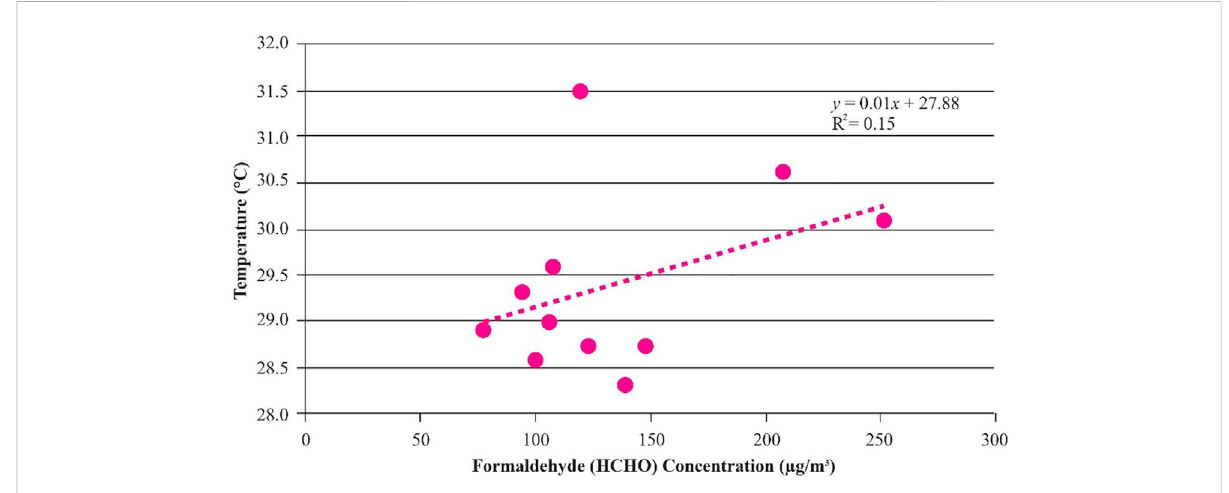
FIGURE 12 Relationship between formaldehyde (HCHO) concentration and temperature.